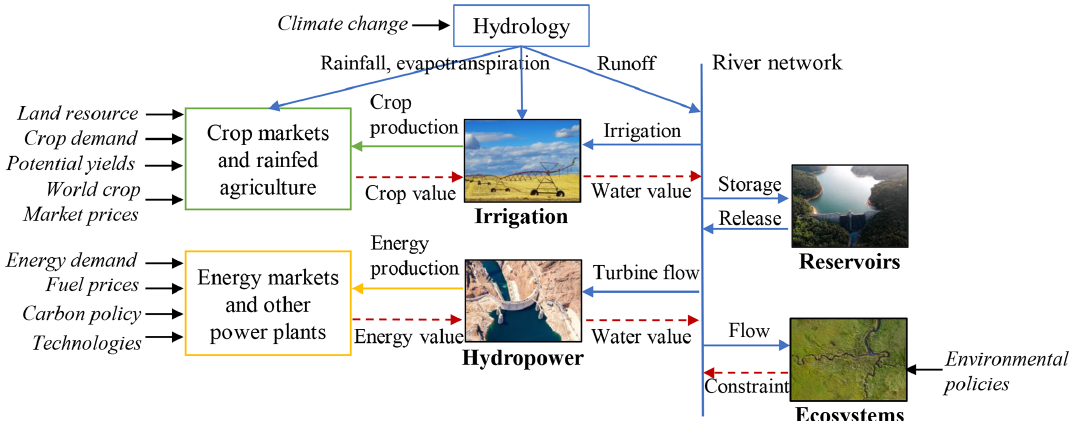
Figure 2. Main feedback loops in the water–energy–food nexus representation. All flows are holistically solved to maximize total economic surplus, and the water, energy, and crop values are the resulting dual values of the mass balance constraints. The figure does not show the temporal and spatial scale of the nexus problem. Factors in italic represent exogenous inputs to the nexus representation.